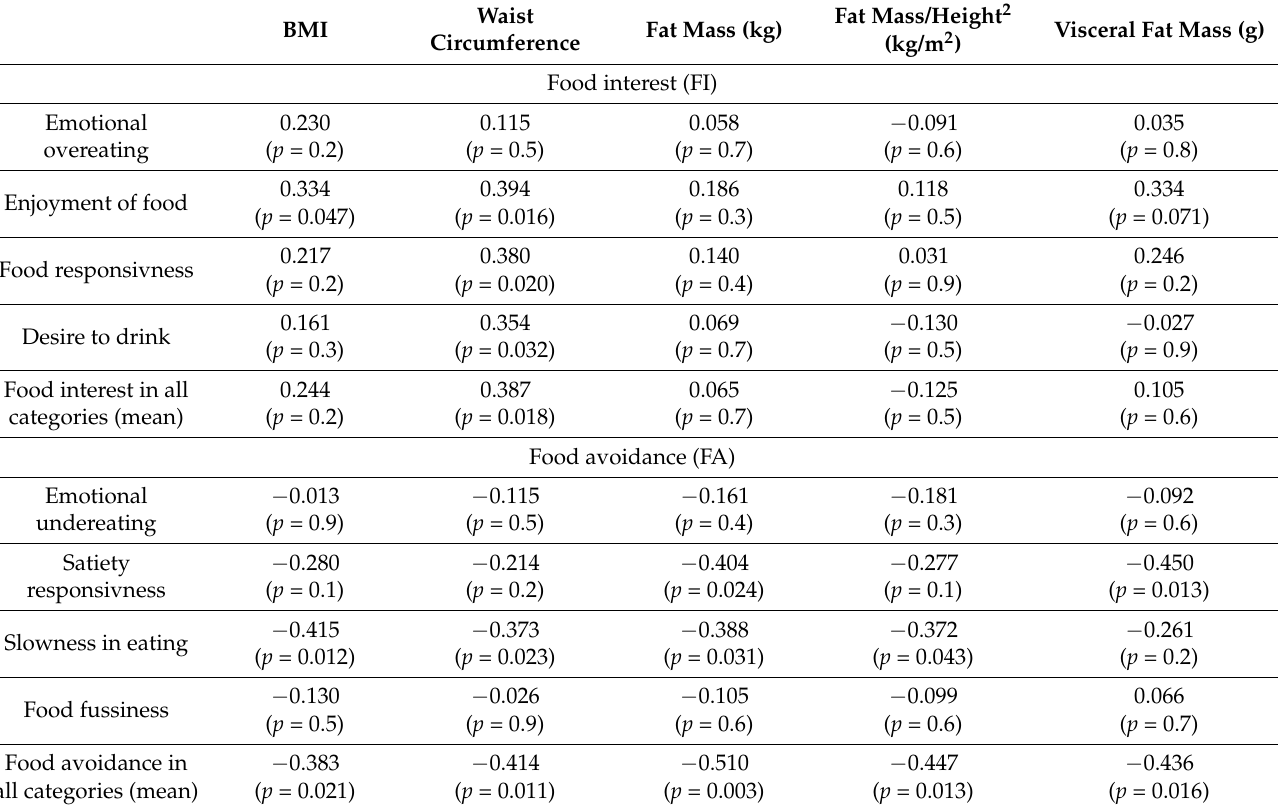
Table 5. Relationship between CEBQ results and parameters of nutritional status.